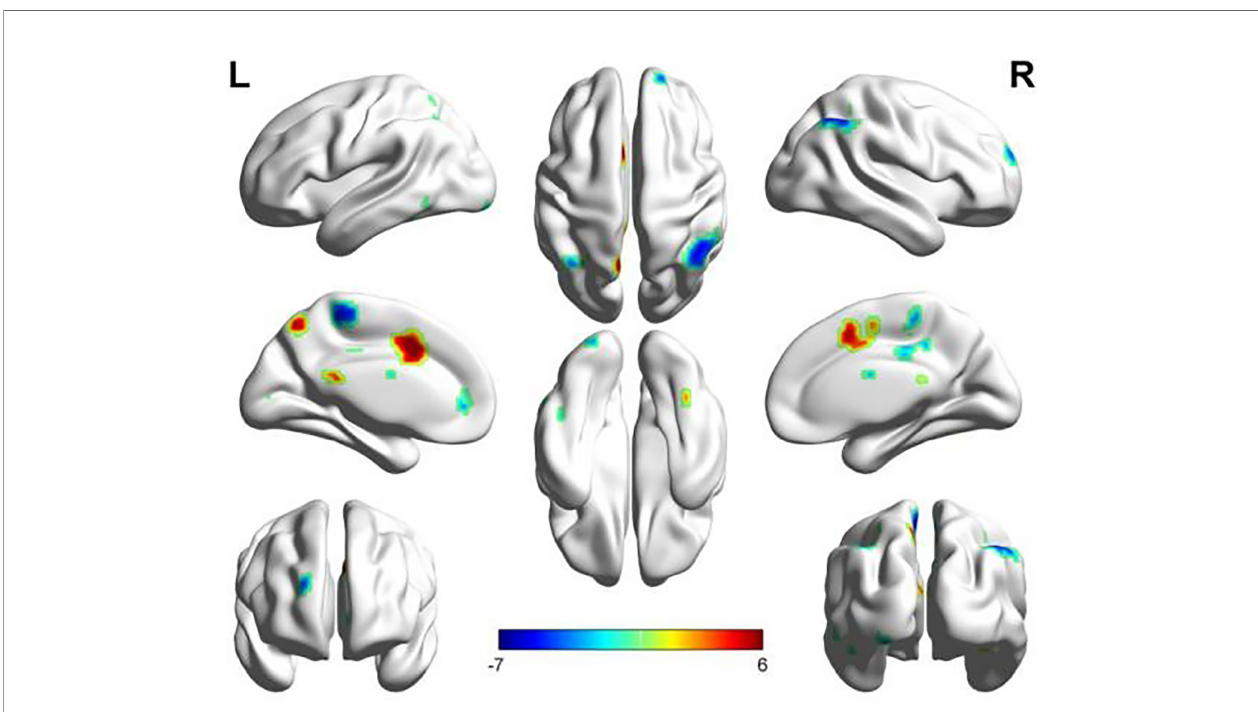
FIGURE 1 | The abnormal brain regions and functional connectivity found in the sensorimotor network in ATM and nATM groups. Red indicates the brain region with enhanced functional connectivity in the ATM group, and blue indicates the brain region with the weakened functional